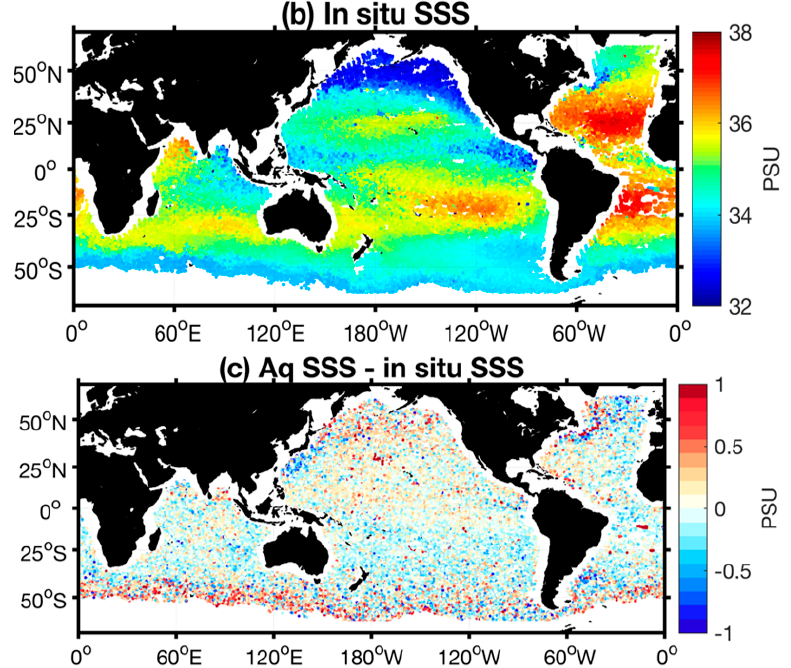
Figure 1. ( a ) Aquarius Level-2 and ( b ) in situ co-located salinity data gathered from September 2011 to May 2015. ( c ) The sea surface salinity (SSS) differences defined as the Aquarius minus the co-located in situ salinity.